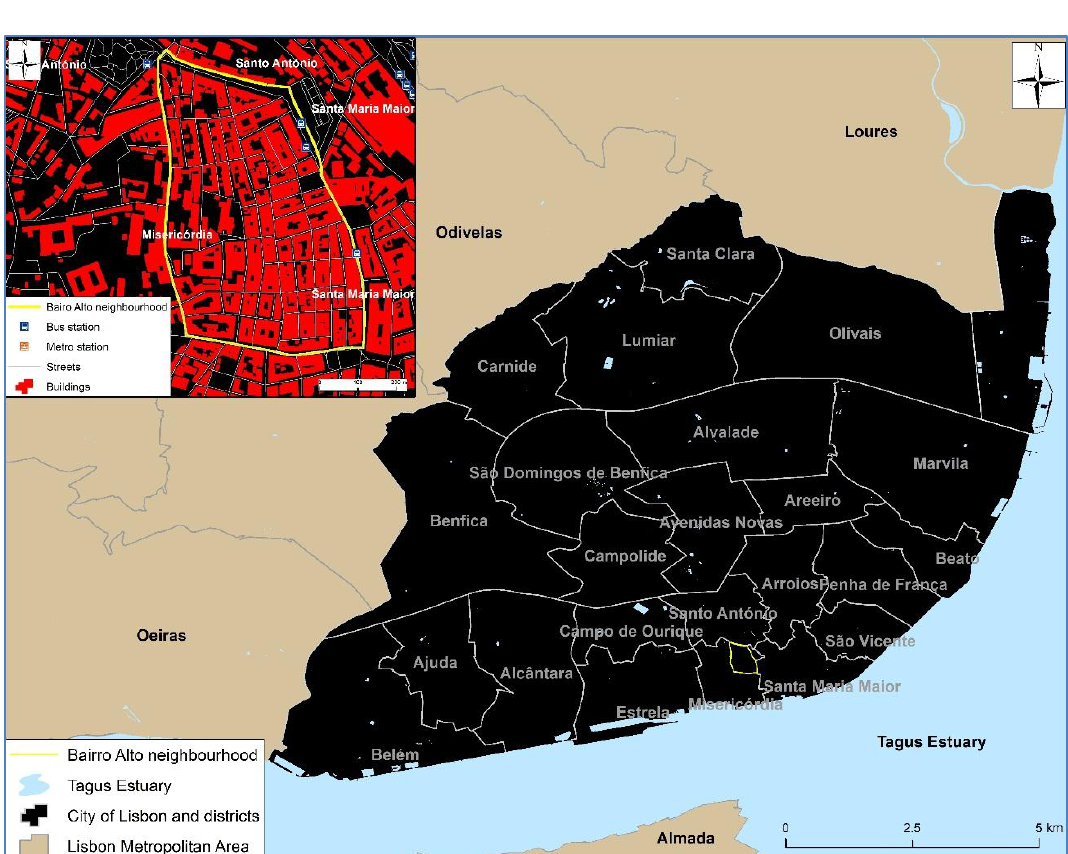
Figure 1: Bairro Alto district of the Portuguese capital, placed in the historical centre of the